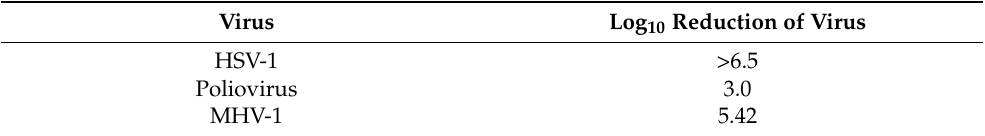
Table 7. Testing of GS-2 (30 mg/mL) with thymol 5 (mg/mL) for surface viricidal activity according to the TMCV 006 ATSM E1053 method for 10 min of exposure; n =